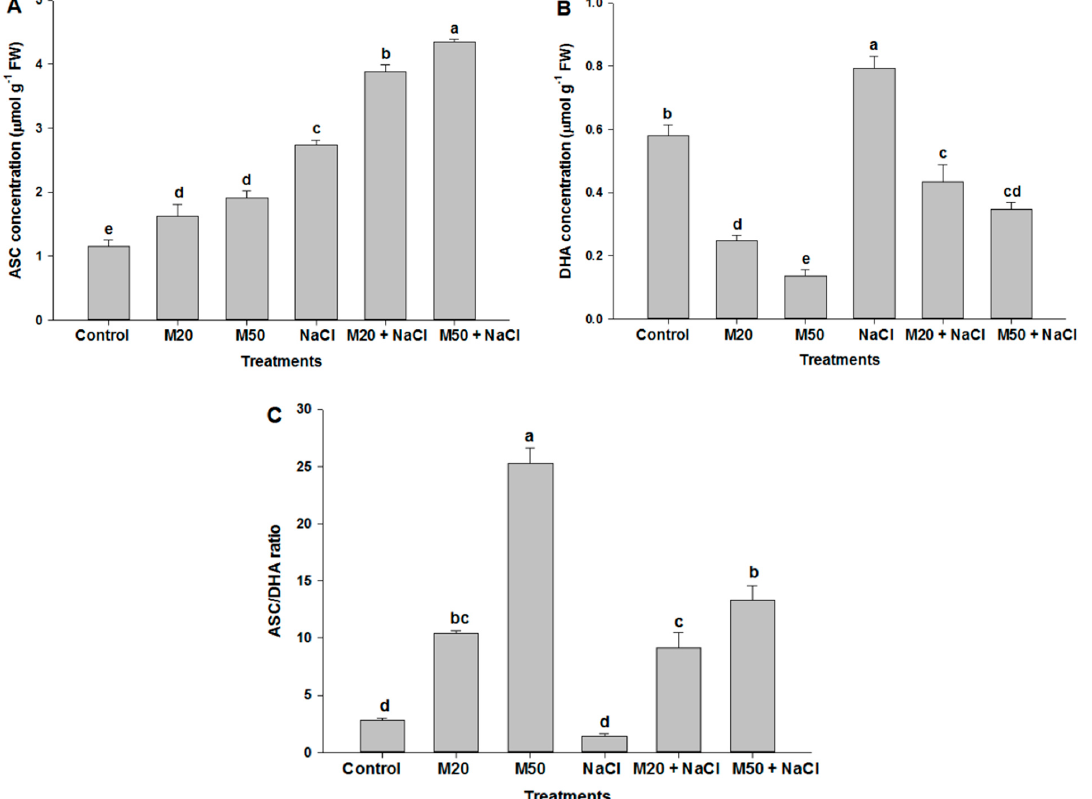
Figure 9. Effect of melatonin on the content of ( A ) ascorbate (ASC), ( B ) dehydroascorbate (DHA), and ( C ) ratio of ASC/DHA in leaves of tomato seedlings under salinity. Data represent mean of 4 replicates with bars indicating SE. The bars labelled with different letters are significantly different at p < 0.05%. [DDW (control), 20 μ M melatonin (20M), 50 μ M melatonin (50M), 100 mM NaCl (NaCl)].